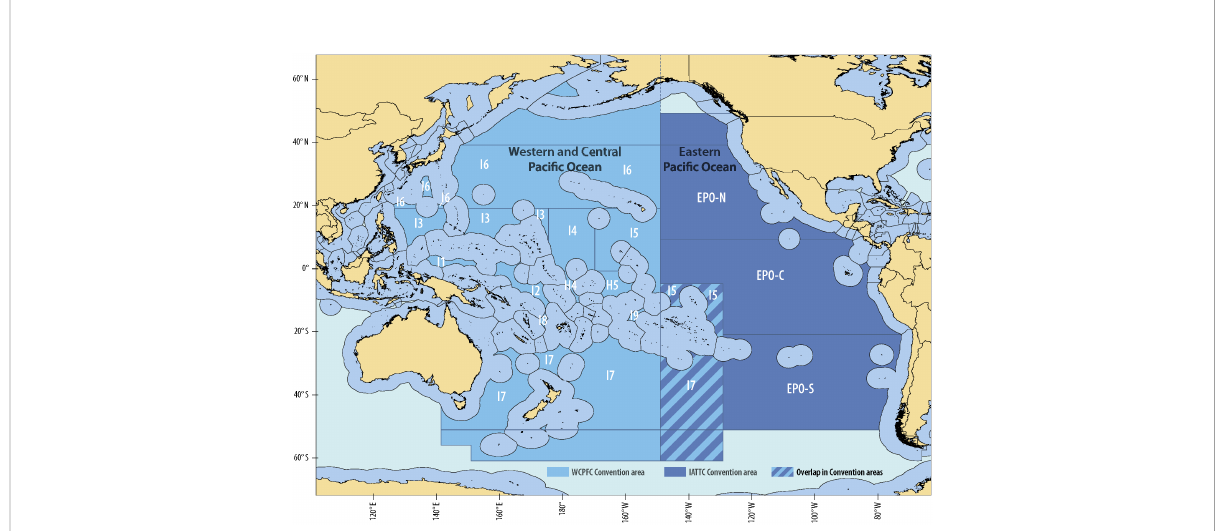
FIGURE 2 Map of the Paci fi c Ocean basin showing the Convention Areas of the Western and Central Paci fi c Fisheries Commission (WCPFC) and the Inter- American Tropical Tuna Commission (IATTC) and the locations of the high seas areas referred to in Table 1. Source: Bell et al.